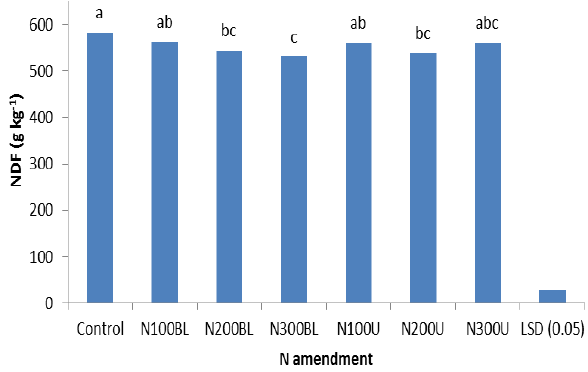
Fig. 7. The effects of N source and rate on ADF concentration of silage corn. Means with the different letters show significant difference (LSD, P ≤ 0.05). See Fig. 2 for Aboveground dry matter Protein yield Protein conc. ADF† S.O.V